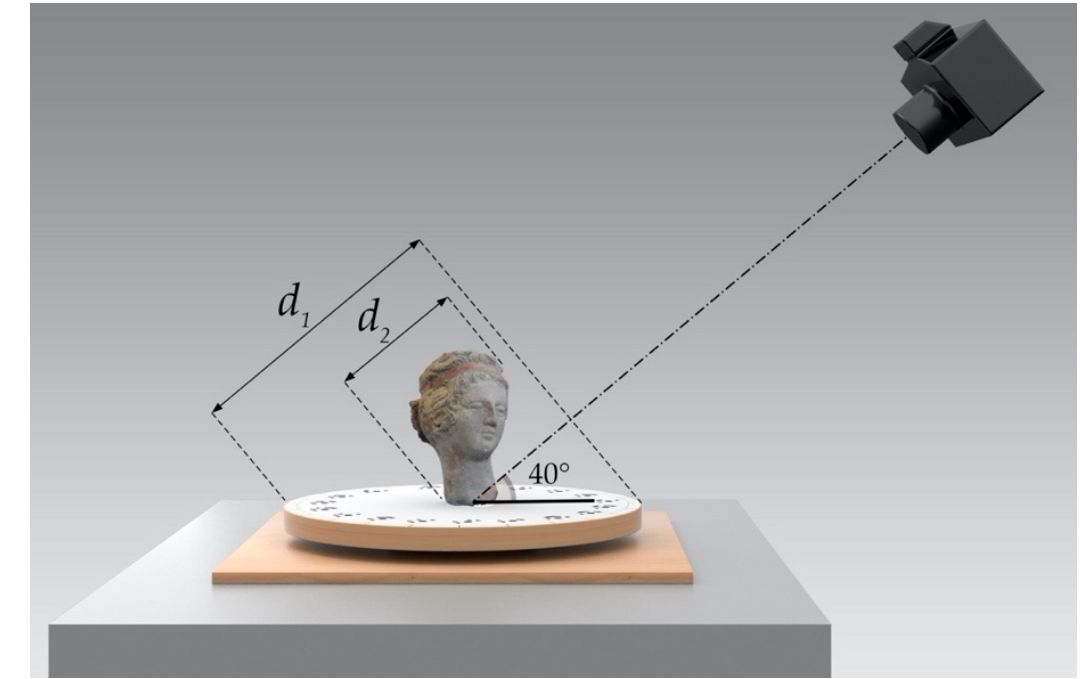
Figure 4. Main issues to ensure an appropriate depth of field using iPhone X. Figure 5. Main issues to ensure an appropriate depth of field using iPhone